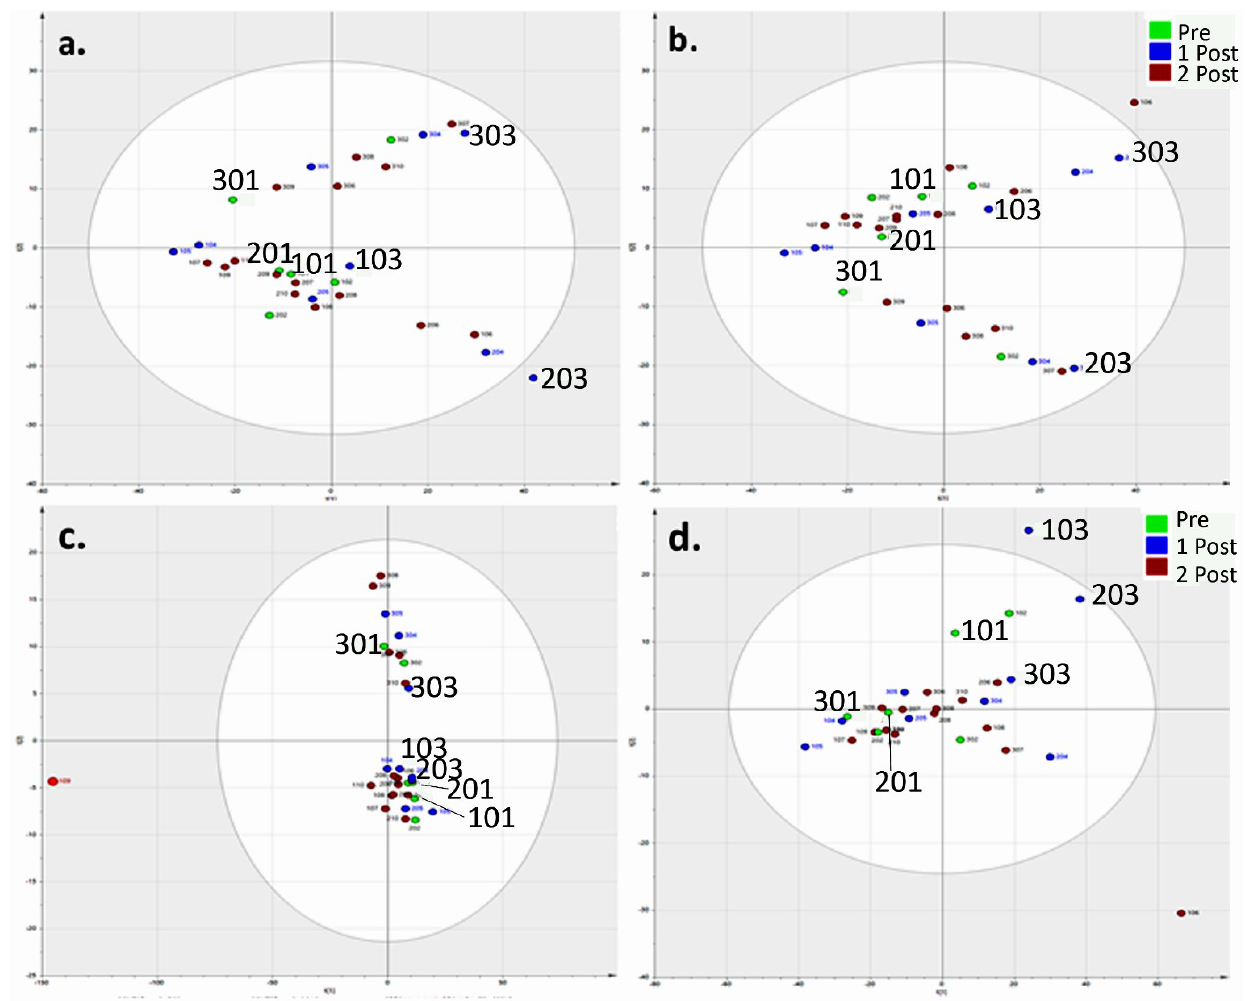
Figure 2. Normalisation strategies applied to the urine metabolome of three subjects (~1,000 putative metabolites). PCA of data normalised to: ( a ) the MS creatinine value of each unique sample detected exhibiting a similar pattern to raw data (R2X: 0.721; Q2: 0.432); ( b ) the MS creatinine value of subject-specific pooled samples ( i.e. , pooled Subject 1 creatinine value utilised to normalise all of Subject 1’s raw data, and so on; R2X: 0.767; Q2: 0.489); ( c ) spectrophotometric creatinine value (the normalised data are closely clustered in the PCA model with the exception of all sampling time-points from Subject 3; R2X: 0.883; Q2: 0.468); and ( d ) subject-specific area percentage (R2X: 0.704; Q2: 0.447; showing the smallest difference between the goodness of fit and predicted fit). The PRE group includes Pre 1 (P1) and P2; the POST1 group includes Post 1 (PT1), 2 and 3; POST2 includes PT4, 5, 6, 7 and